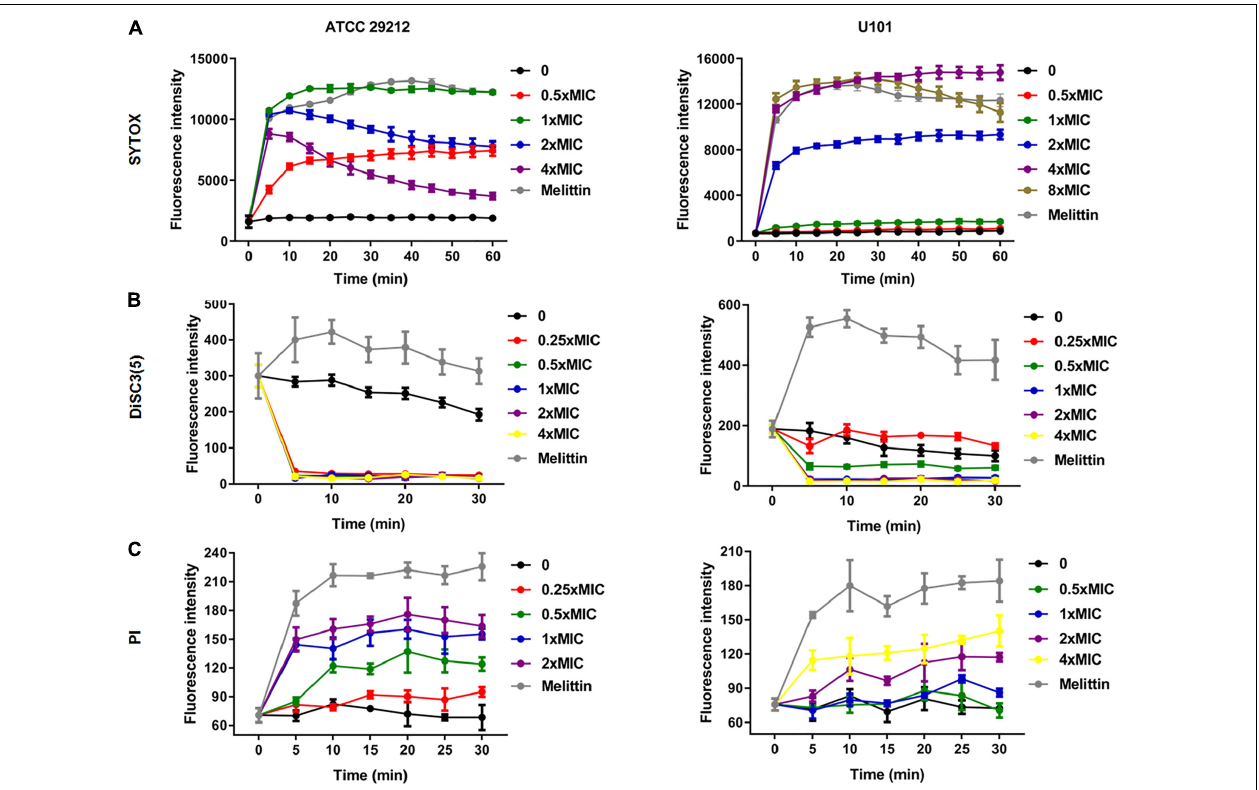
FIGURE 2 | Bacterial cell membrane-disrupting effects of BT against Enterococcus. Bacterial cells were washed with PBS and treated with BT, and fluorescent dyes were used to monitor the disruption of cell membrane integrity. (A) SYTOX was used to stain the disrupted cell membranes, (B) DiSC3(5) was used to detect the exchange of intracellular potassium ions, and (C) PI bound to the DNA inside the cells with the disrupted cell